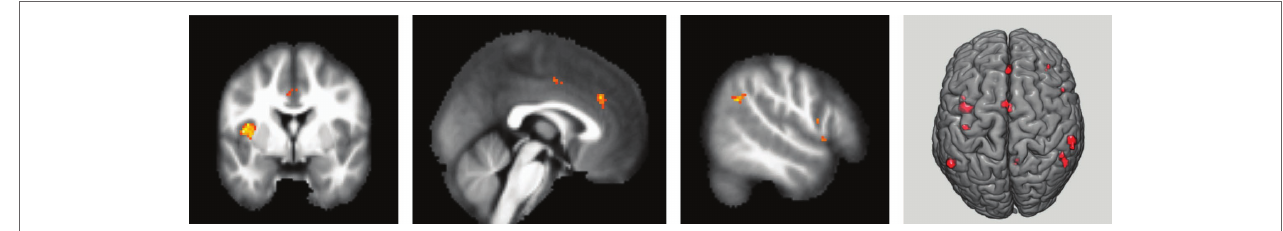
FIGURE 4 | Areas of activation in contrast between intrusion versus goal-directed thoughts. p < 0.05 (FWE). T1-weighted MR image with highlighted areas of significant difference in hemodynamic response when emergence of intrusive thought was compared with goal-directed cognition (from left to right: left insula and dACC; left dACC; right angular and orbitofrontal gyrus; the same contrast displayed on 3D brain model). Minimal voxel size of the display area is five voxels, FWE-corrected voxel-wise threshold. Results of a group of 11